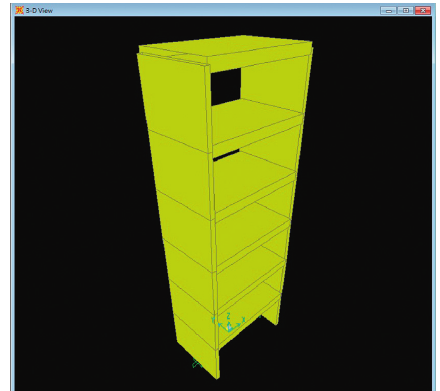
Figure 5: The six-story shear frame